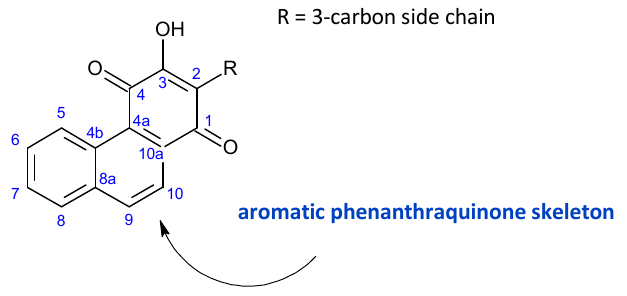
Figure 6. Skeleton of 1,4-phenanthraquinones Figure 6. S keleton of 1,4-phenanthraquinones [29].